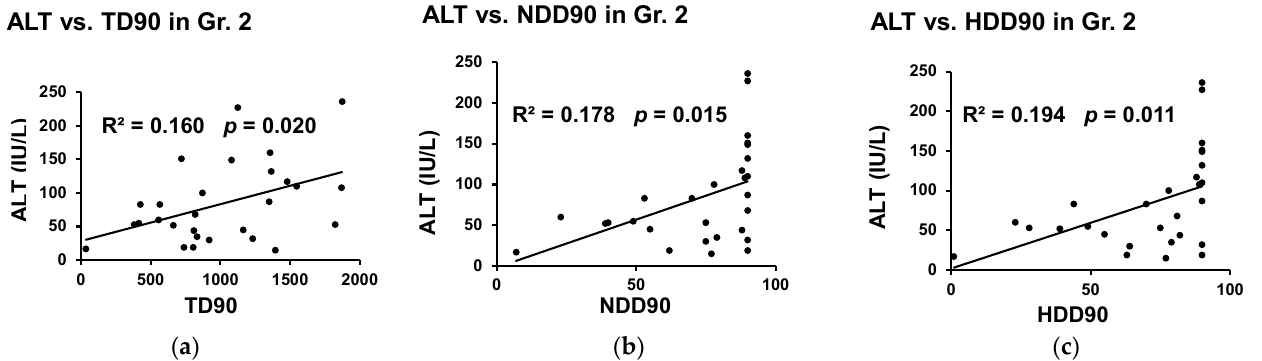
ALT vs. TD90 in Gr. 2